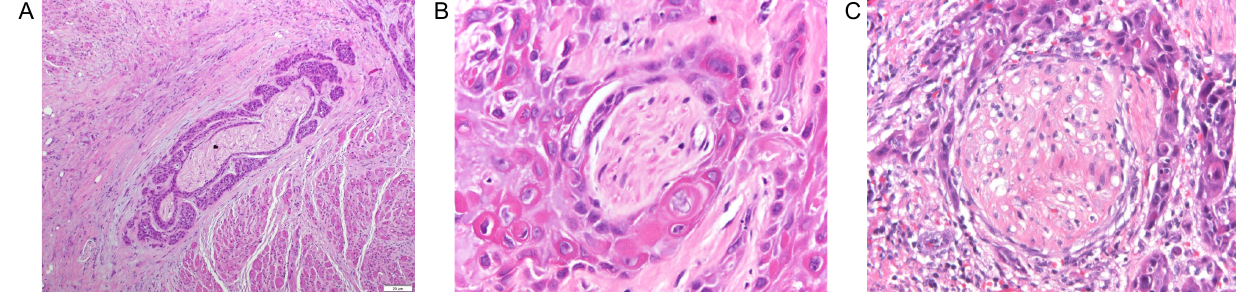
Figure 3. Histopathology of perineural involvement in oral cavity squamous cell carcinoma (SCC). Hematoxylin and eosin-stained histopathological sections of oral cavity SCC demonstrating various types of perineural invasion: ( A ) perineural spread along a longitudinal cut of nerve (10×), ( B ) complete encirclement (60×), and ( C ) incomplete “crescent-like” encirclement of nerves superiorly (40×).